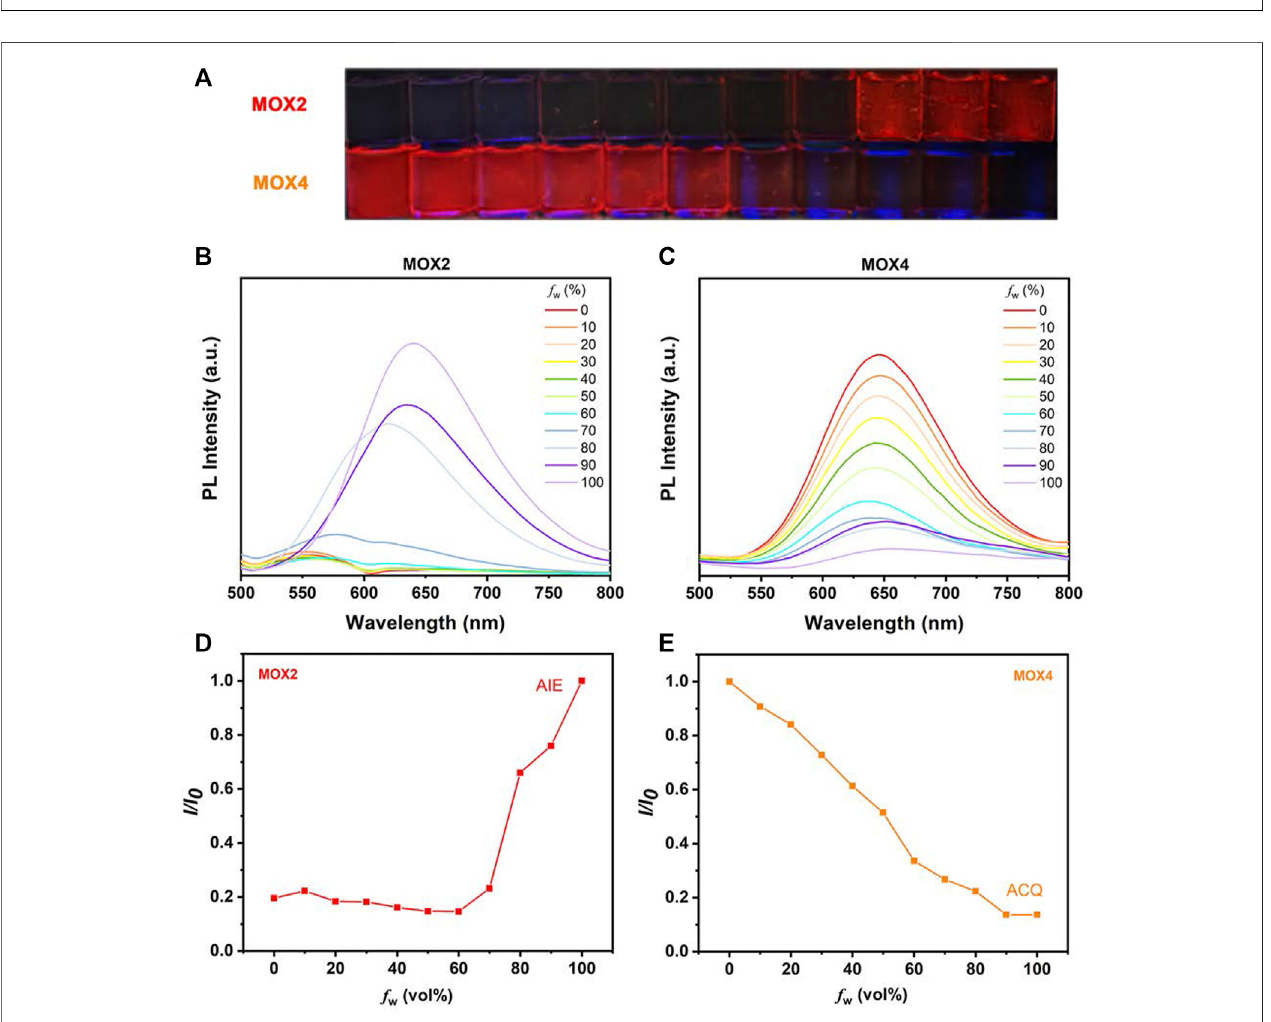
FIGURE 4 | (A) The photos in different solvent states of MOX2 and MOX4 at 365 nm (10 µM). (B) The MOX2 PL spectra as a function of the water fraction in DMSO. (C) The MOX4 PLspectraasafunctionofthewaterfractioninDMSO. (D) VariationinPLintensity( I/I 0 )of MOX2 with f w (%),whereI 0 istheluminescenceintensity in pure H 2 O. (E) Variation in PL intensity ( I/I 0 ) of MOX4 with f w (%), where I 0 is the luminescence intensity in pure DMSO.